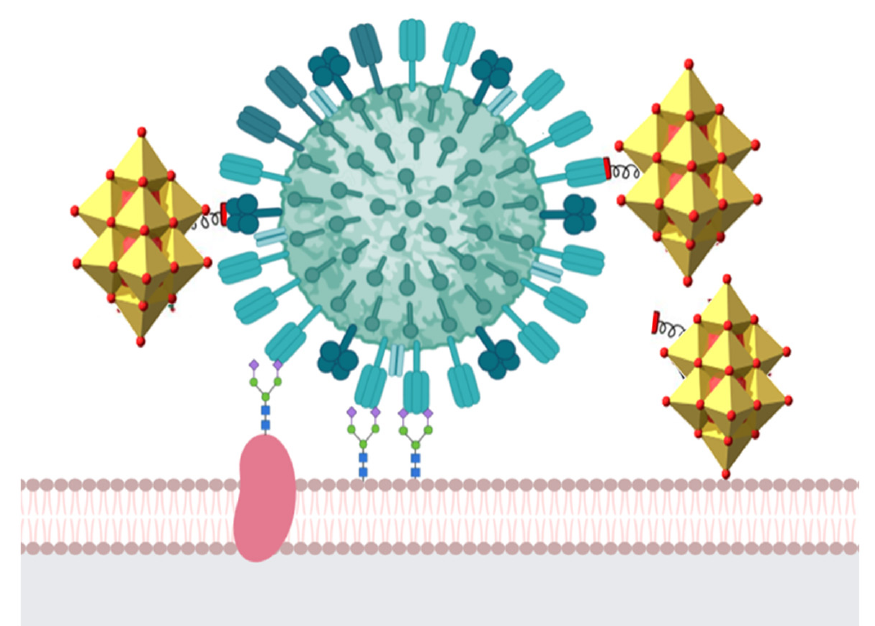
Figure 4. POM putative interactions with viral membrane proteins, such as hemagglutinin, prevent-